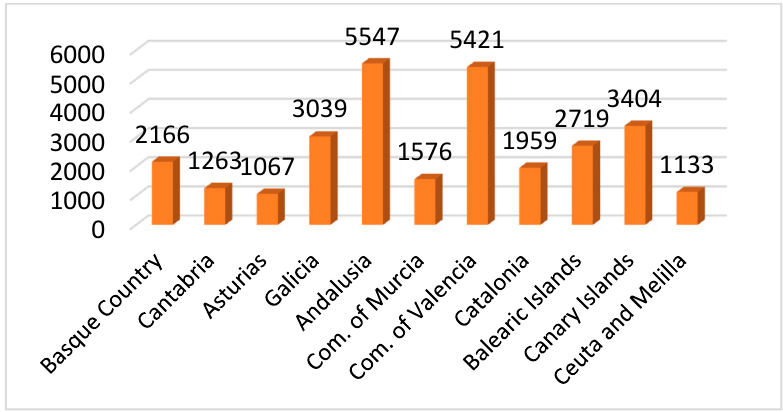
Figure 4. Distribution of fleet emissions by coastal regions in Spain. Source: Authors. By groups of age (A), until the year 2015, the fleet of ships under 10 years old was the one that emitted the highest quantity of Tm of CO 2 equivalent. After 2015, however, it is the fleet of tugboats of over 15 years of age that produces the highest quantity of greenhouse gas emissions in the Spanish ports. In Figure 5, the x -axis shows the emissions of tons of CO 2 and the y -axis shows the years.